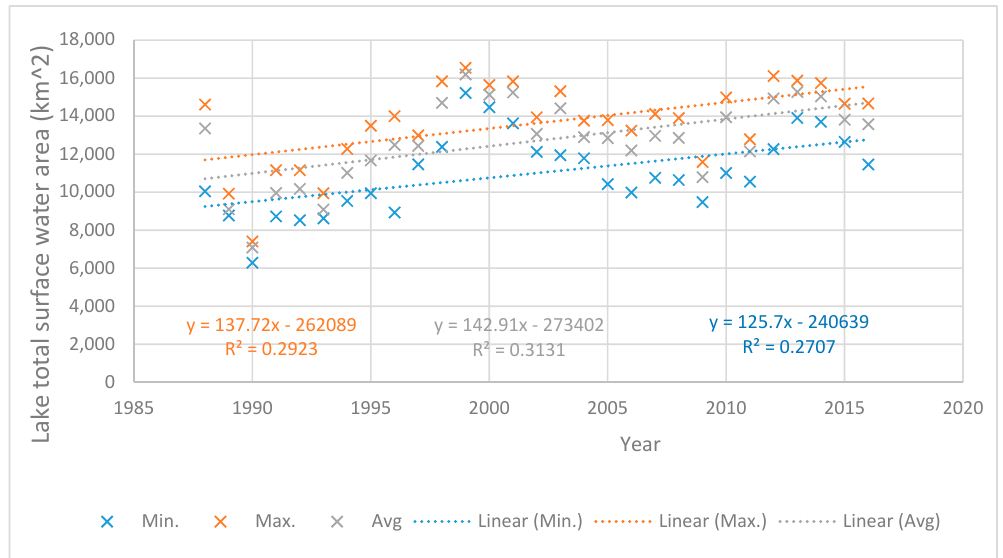
Figure 8. Annual mean, maximum, and minimum Lake Chad dry season total surface water area time series composite from [10] and the research for this paper. Each data point represents a full month. Trend lines are included.